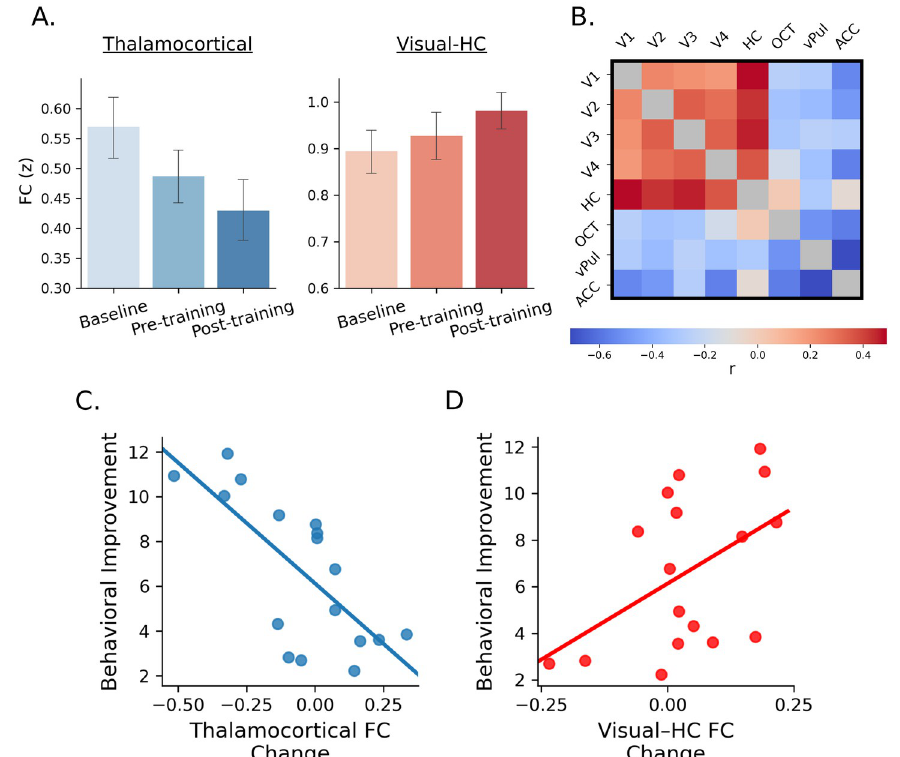
Fig 3. Thalamocortical and visual-hippocampal networks. ( A ) Visual-hippocampal network functional connectivity (V1, V2, V3, V4, HC) increased, while thalamocortical network functional connectivity (OCT, vPul, ACC) decreased after training. ( B ) Correlation matrix (units: Pearson’s r) showing the relationship between change (post-training–pre- training) in functional connectivity between cortical and subcortical regions and behavioral improvement. ( C ) Significant negative correlation between change in mean thalamocortical network functional connectivity and behavior improvement (r = − 0.71, p = 0.001, CI [ − 0.88, − 0.45]). ( D ) Significant positive correction between change in mean visual-hippocampal network functional connectivity and behavior improvement (r = 0.48, p = 0.050, CI [0.03, 0.78]). ( n = 17). Source data are provided at: https://doi.org/10.17863/CAM.93457. ACC, anterior cingulate cortex; OCT, occipito-temporal cortex; vPul, ventral